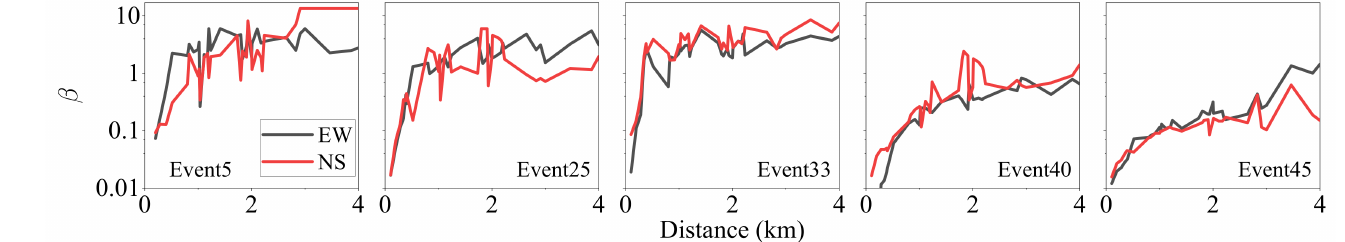
Figure 14. The evolution of β with respect to distance.